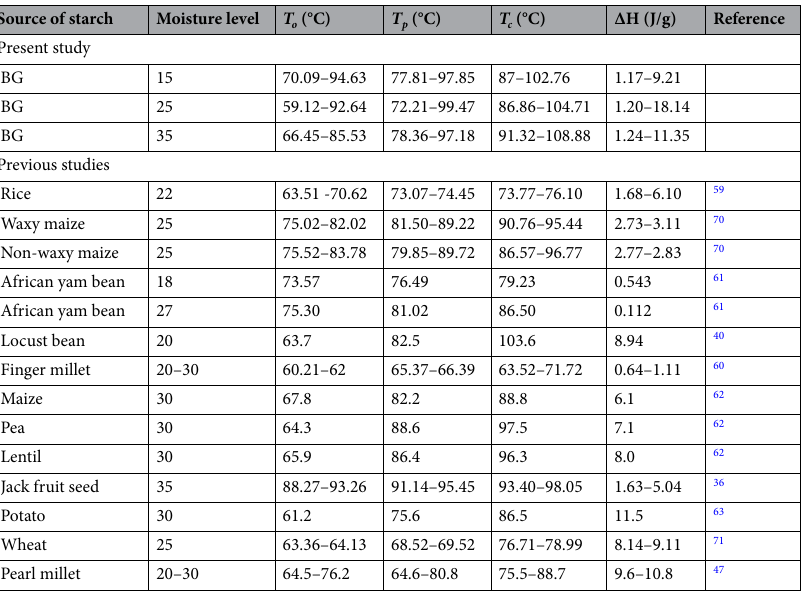
Table 8. Comparison of gelatinization temperatures of the present study with previous studies. T o : onset temperature; T p : peak temperature; T c : conclusion temperature; ∆H: Gelatinization enthalpy; BG: Bambara